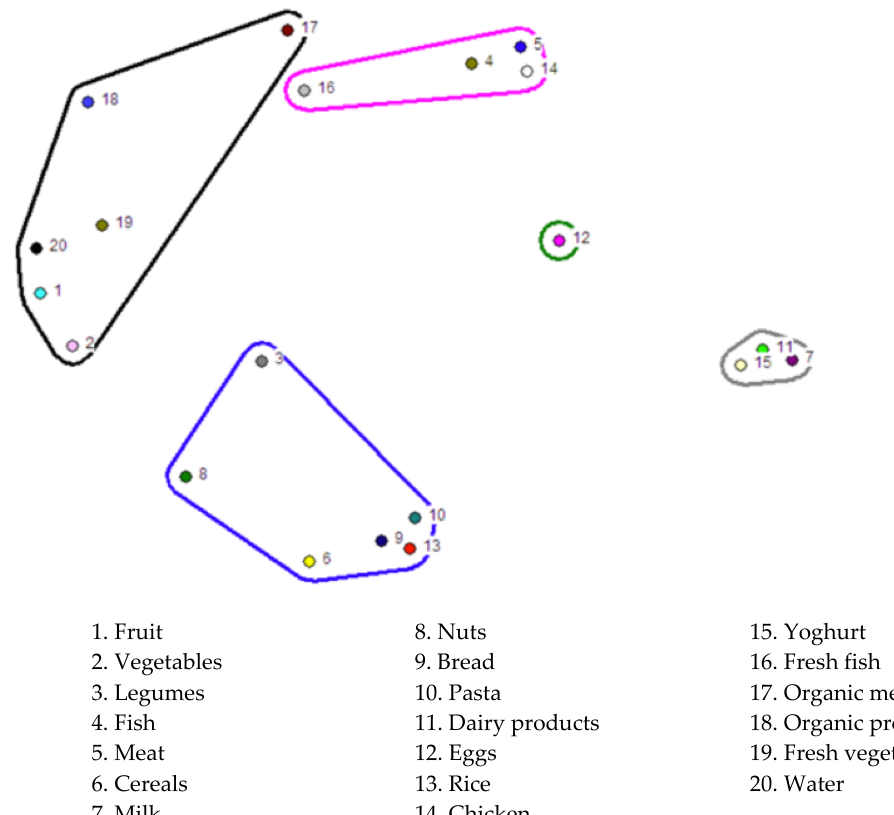
Figure 2. Nonmetric multidimensional scaling (nMDS) of trust in food. Representation of the total number of pile sorts ( n = 62), showing the proximity/distance of the categories in the women’s perceptual universe. The nMDS model allows for various interpretations, and therefore the proposed item areas are tentative. The numbering corresponds to the following categories. Interpretation of the clusters or dimensions: blue: cereals, legumes and nuts; black: trusted items due to the nutritional properties of the food itself and/or its origin and manipulation; pink: items characterised by ambivalence regarding (mis)trust; green: eggs; grey: dairy